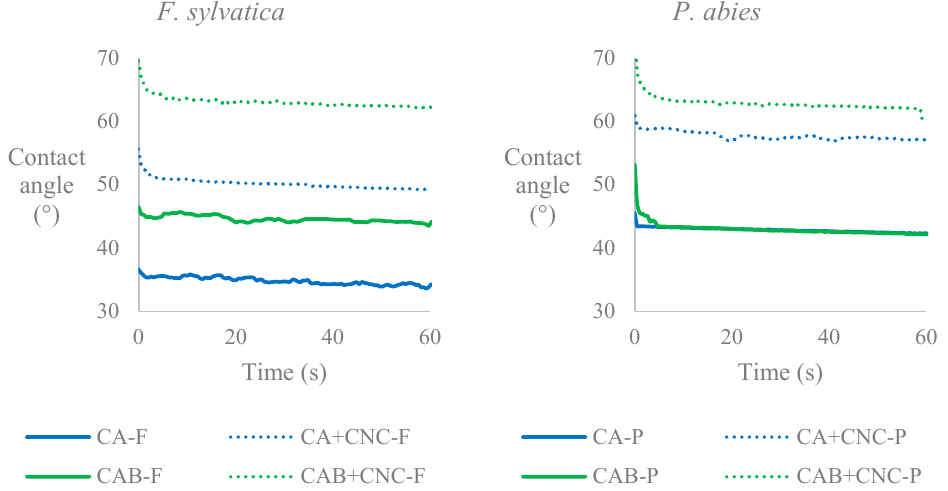
Figure 7. Contact angle analysis of the coatings applied on beech and spruce wood. CA: Commercial acrylic waterborne coating. CA+CNC: CA with addition of 2% CNC gel. CAB: Commercial acrylic waterborne coating with biocides. CAB+CNC: CAB with addition of 2% CNC gel.